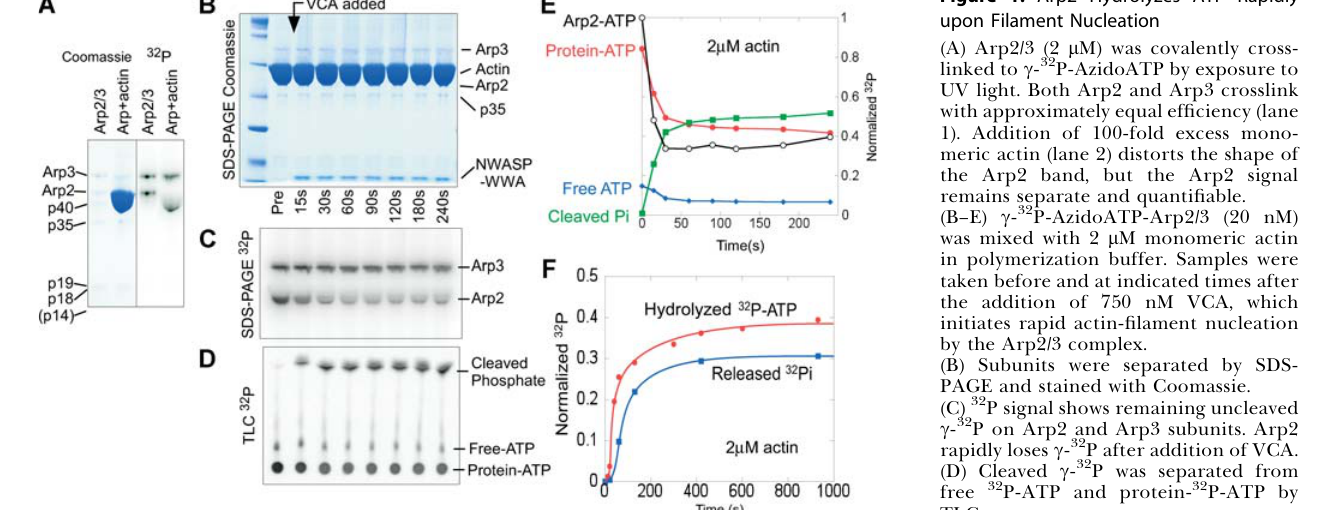
(F) Arp2 releases phosphate soon after ATP hydrolysis. Reaction conditions were the same as (B)–(E), but with the addition of 2 mM maltose and 2 U/ml maltose phosphorylase. Timepoints were quenched into formic acid and assayed by TLC. Hydrolyzed 32 P-ATP was quantified from the decrease in protein conjugated 32 P, and released 32 P was quantified from the 32 P-glucose phosphate produced. DOI: